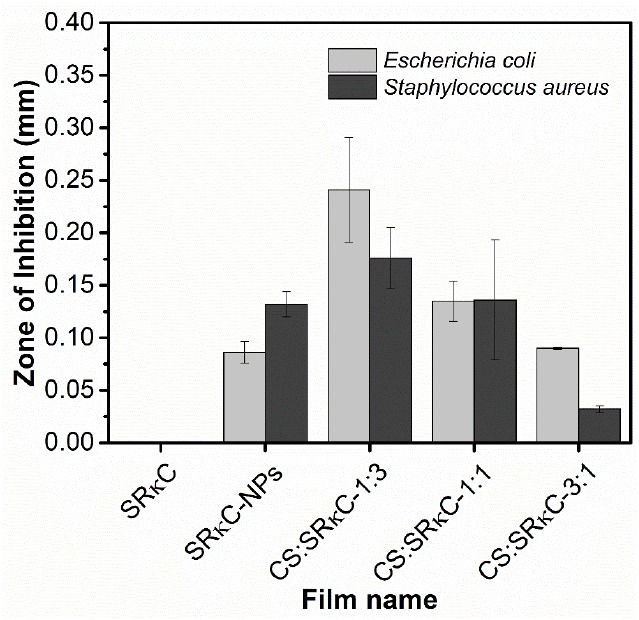
Figure 8. Inhibition zone of as-prepared bionanocomposite films.